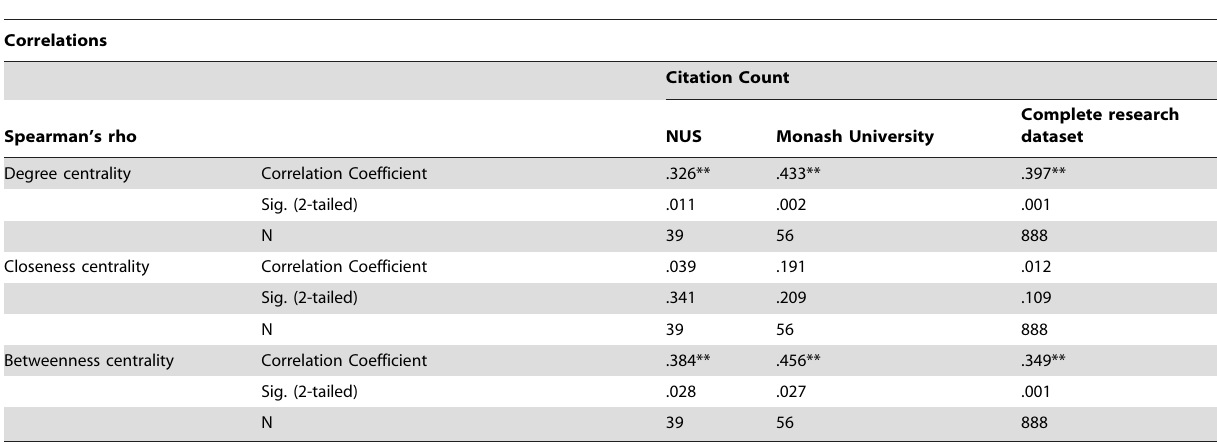
Table 3. Correlation matrix between three network centrality measures and citation count .